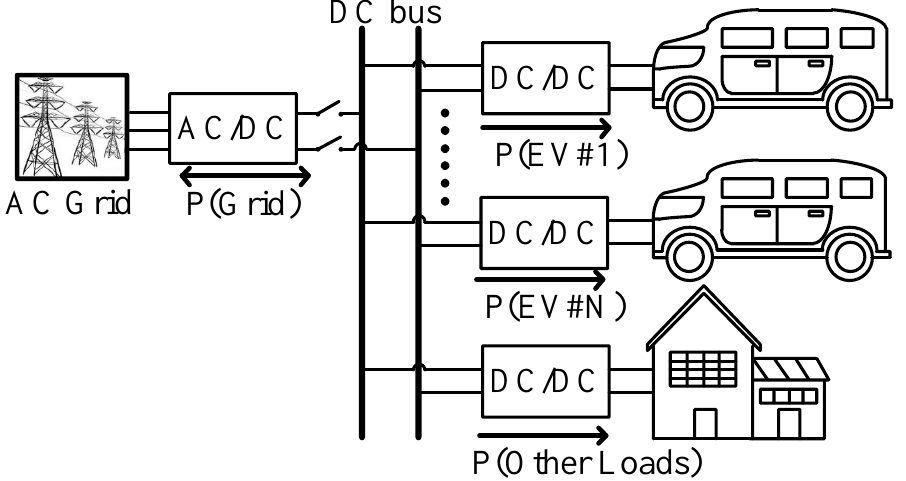
Figure 5. Typical system configuration of a grid-connected ECS without renewable energy (RE)-based power generation and energy storage systems (ESSs).